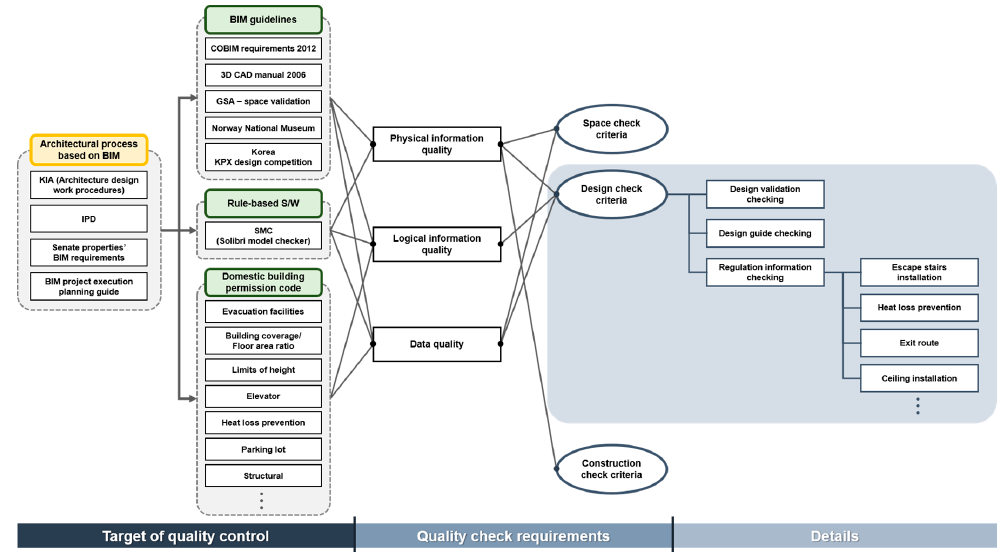
Figure 1. Relevance of quality control target and criteria.